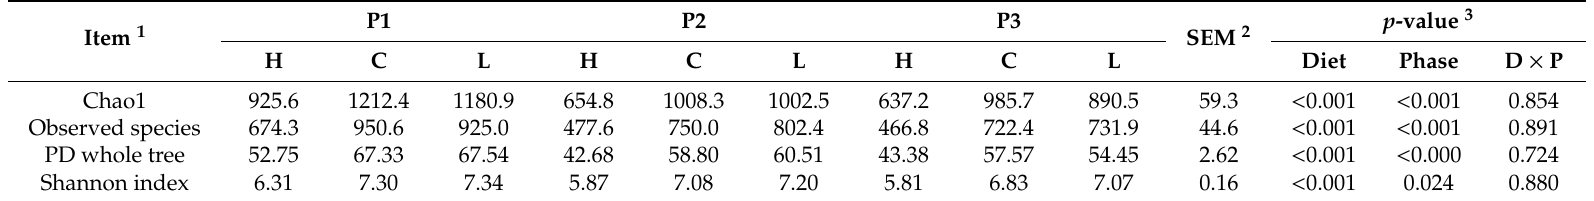
Table 3. Fecal Alpha Diversity Indices of Holstein Steers Fed with Three Stepwise Density